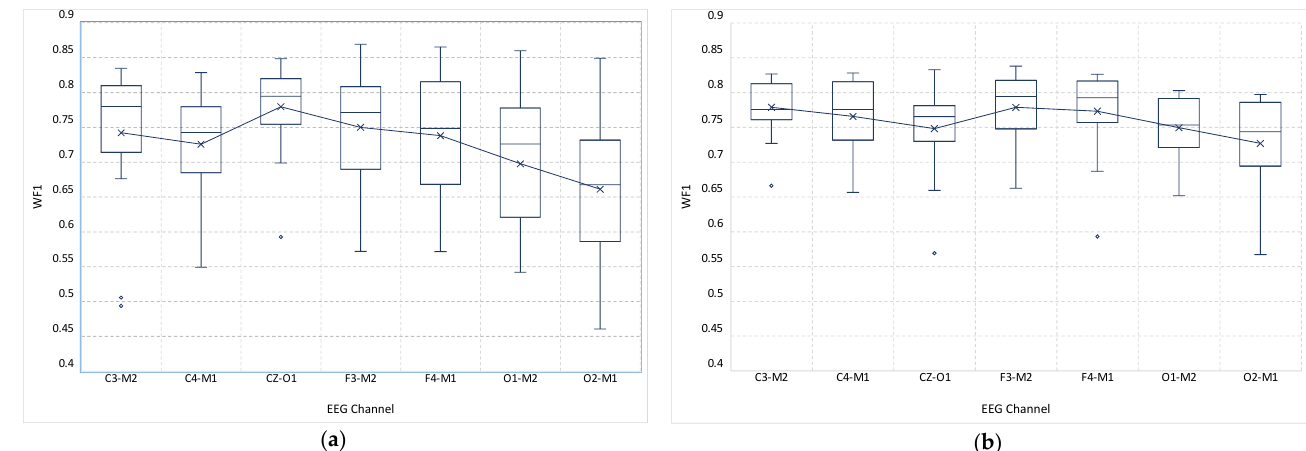
Figure 4. Box plot of the average WF 1 of each EEG channel over all age groups for ( a ) DeepSleepNet and ( b ) AttnSleep algorithms. AttnSleep achieved higher average WF 1, and less performance variation over different age groups compared to DeepSleepNet.